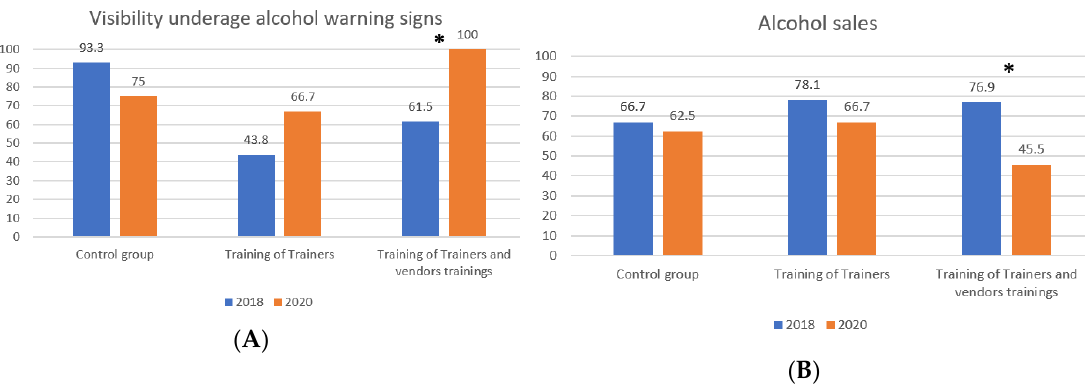
Figure 2. Proportion of supermarket visits by year and type of training. ( A ) Proportion of supermarket visits where underage alcohol warning signs were visible and ( B ) proportion of alcohol sales to minors. * = statistically significant differences were found.